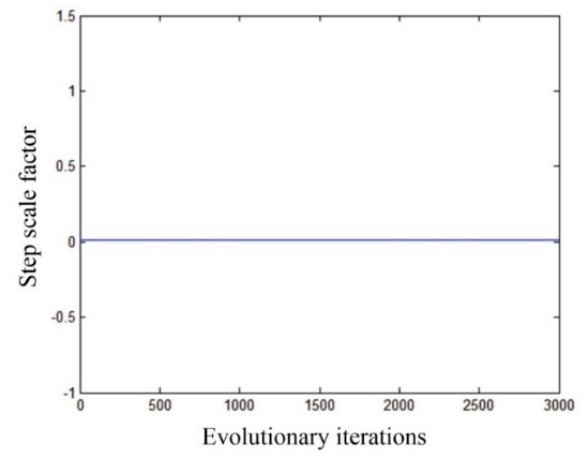
Figure 2. 𝛼 (cid:2868) (30 dimensions) in the evolution of the standard CS algorithm. Figure 2. α 0 (30 dimensions) in the evolution of the standard CS algorithm.